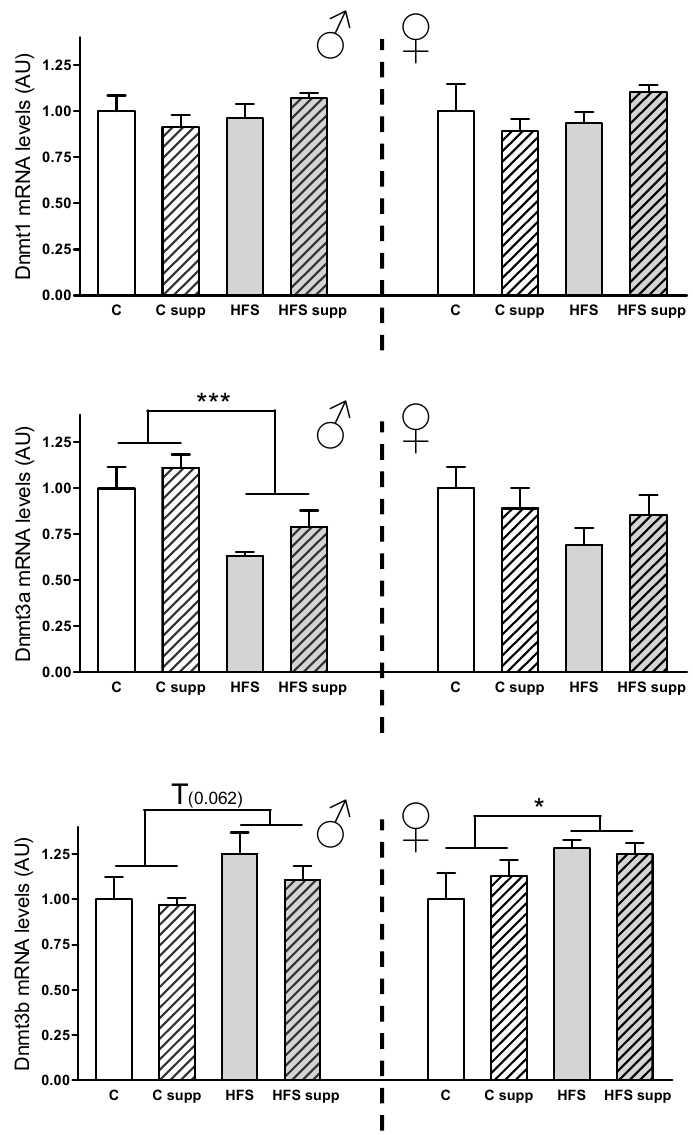
Figure 5. Liver mRNA levels from DNA methyltransferases from male and female offspring depending on maternal nutrition during lactation. Data are reported as means ± SE ( n = 6 from each experimental group). C, control; C supp, control supplemented; HFS, high-fat-sucrose; HFS supp, high-fat-sucrose